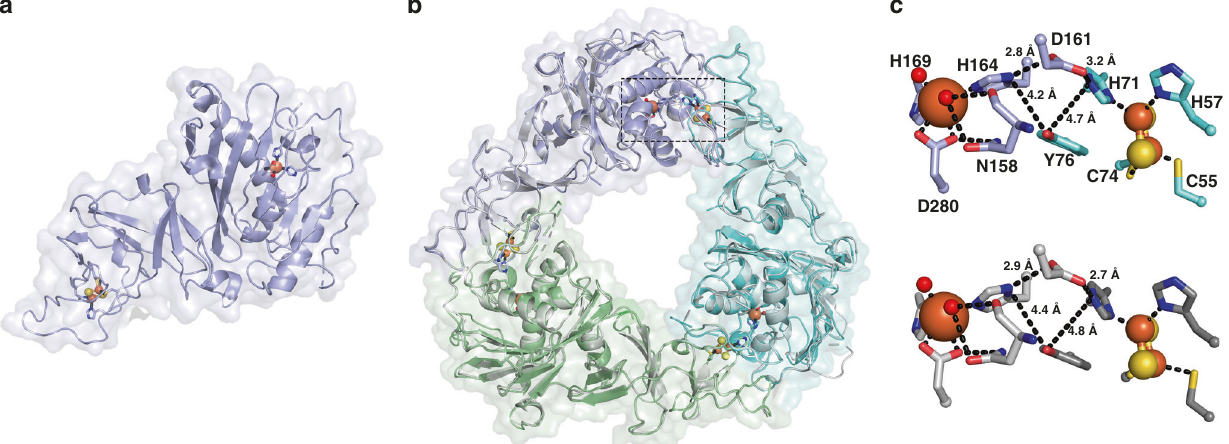
Fig. 2 SxtT and GxtA showcase structurally similar trimeric architectures and metallocenter arrangements. a The monomeric unit of SxtT reveals that the metallocenters are located approximately 45-Å apart. b The trimeric quaternary structures of SxtT (colors) and GxtA (gray) are overlaid with one another. The trimeric arrangement of subunits allows for the close positioning of the metallocenters. c Two residues, Asp161 and Tyr76, which are found at the subunit-subunit interface of both SxtT (top panel) and GxtA (bottom panel, same residue numbering as SxtT) bridge the Rieske cluster to the non- heme iron center. SxtT is shown in purple and cyan and GxtA is